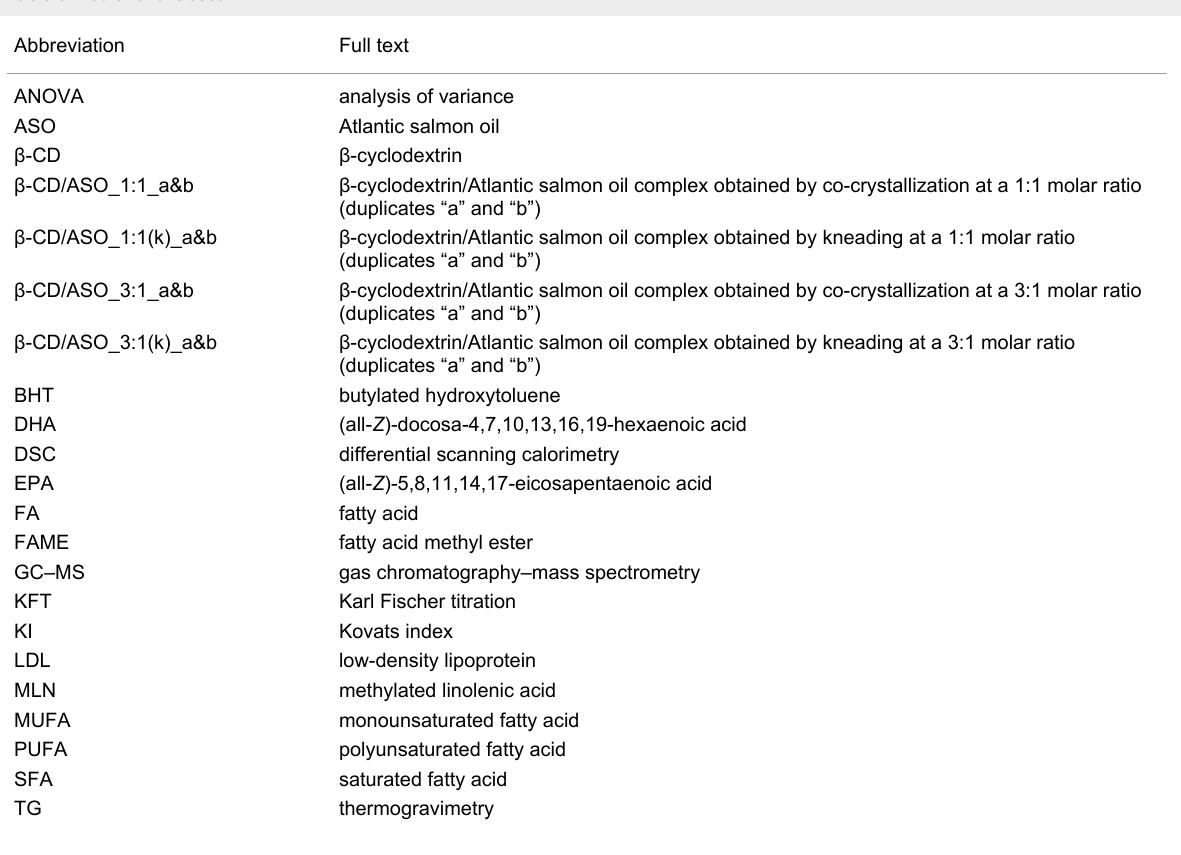
Table 3: Abbreviations